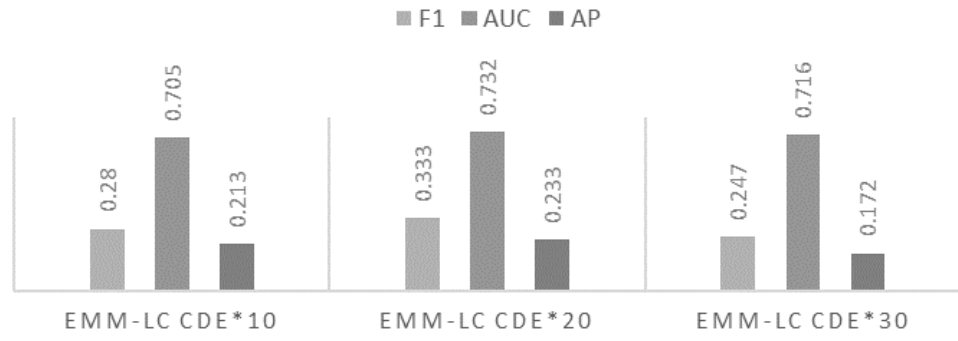
Figure 9. Varying the degree of inflation with DAE.